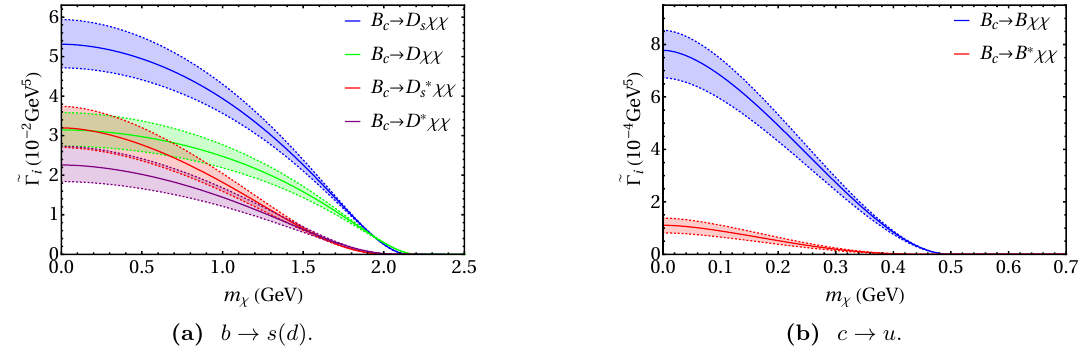
(cid:0) P ( V ) (cid:31)(cid:31) process. The shadows represent c ! (cid:6)